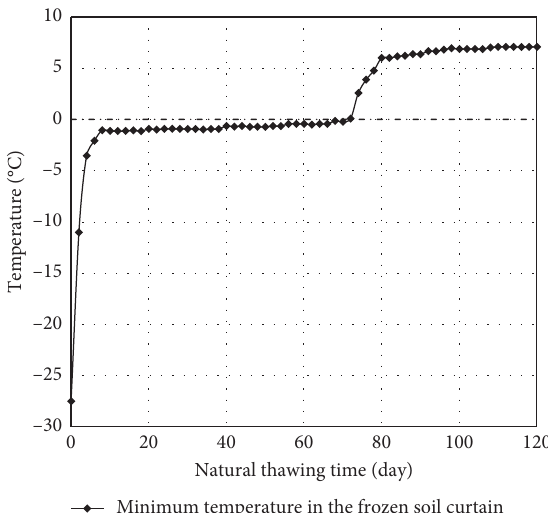
Figure 9: Variation of minimum temperature in the frozen soil curtain with natural thawing